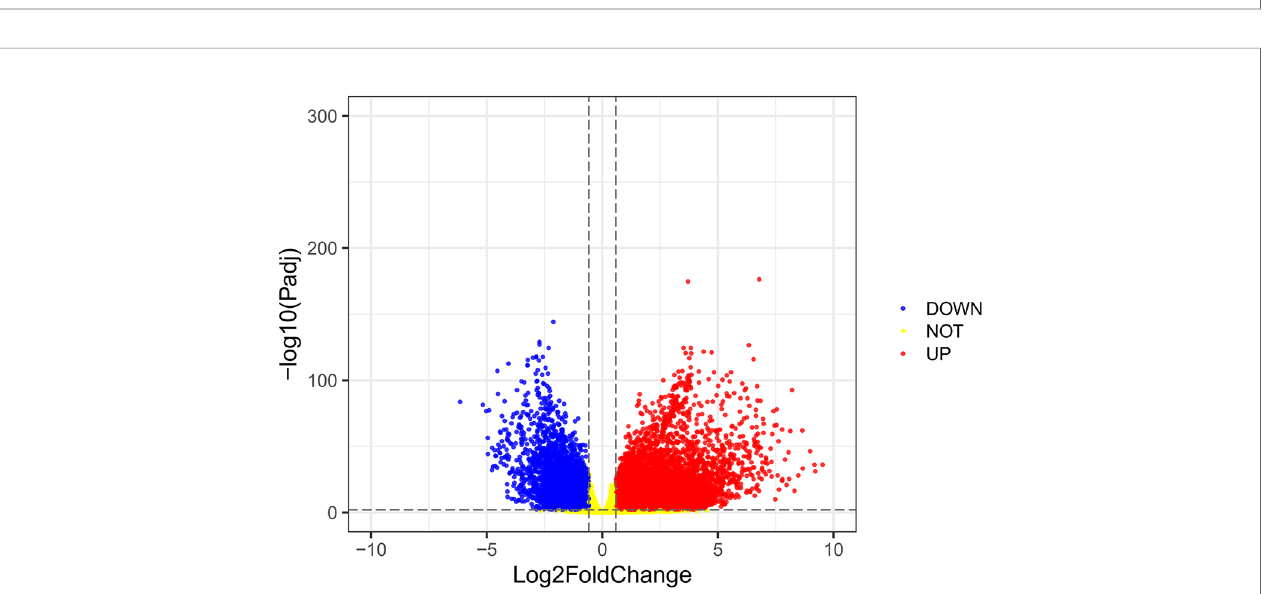
FIGURE 2 | A volcanic map of differential gene expression. The red dot represents the upregulated mRNAs, and the green dot represents the downregulated